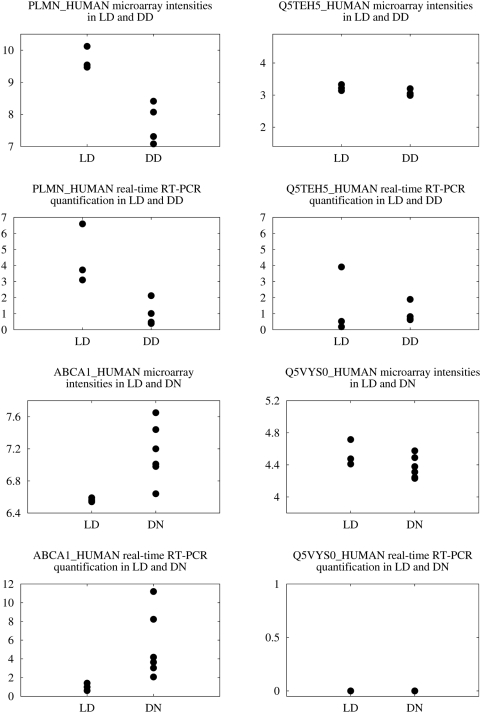
Microarray and real-time RT-PCR transcript measurements of PLG and ABCA1 in two patient cohorts.For the gene PLG, transcript PLMN_HUMAN was repressed in DD compared to LD controls, while Q5TEH_HUMAN showed no differential expression. Real-time RT-PCR measurements on the same tissues were in agreement with these findings. For gene ABCA1, transcript ABCA1_HUMAN was induced in DN compared to LD, and Q5VYS0_HUMAN was not regulated. Real-time RT-PCR measurement confirmed the induction of ABCA1_HUMAN. Q5VYS0_HUMAN was expressed at a too low level to be measured (value 0). Real-time data are normalized to the cohort with lower abundance.